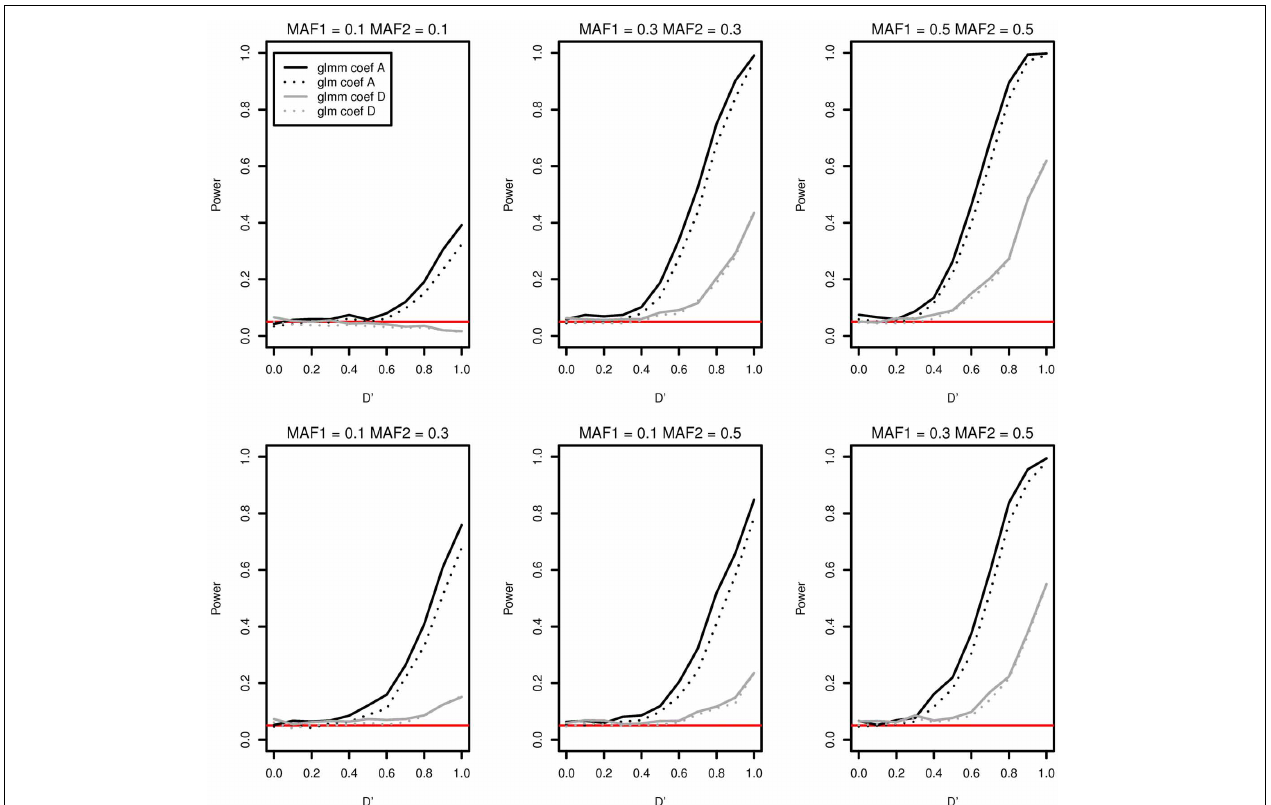
coef A : β 1 = 0, β 2 = 0, and β 12 = 0 . 5 (shown in black), coef D : β 1 = 0 . 75, = 10 and σ 2 = 0 . 01, and the β 2 = 0 . 75, and β 12 = 0 . 25 (shown in gray), σ 2 a e sample size is 2000 (400 families). The red horizontal line indicates the 0.05 significance